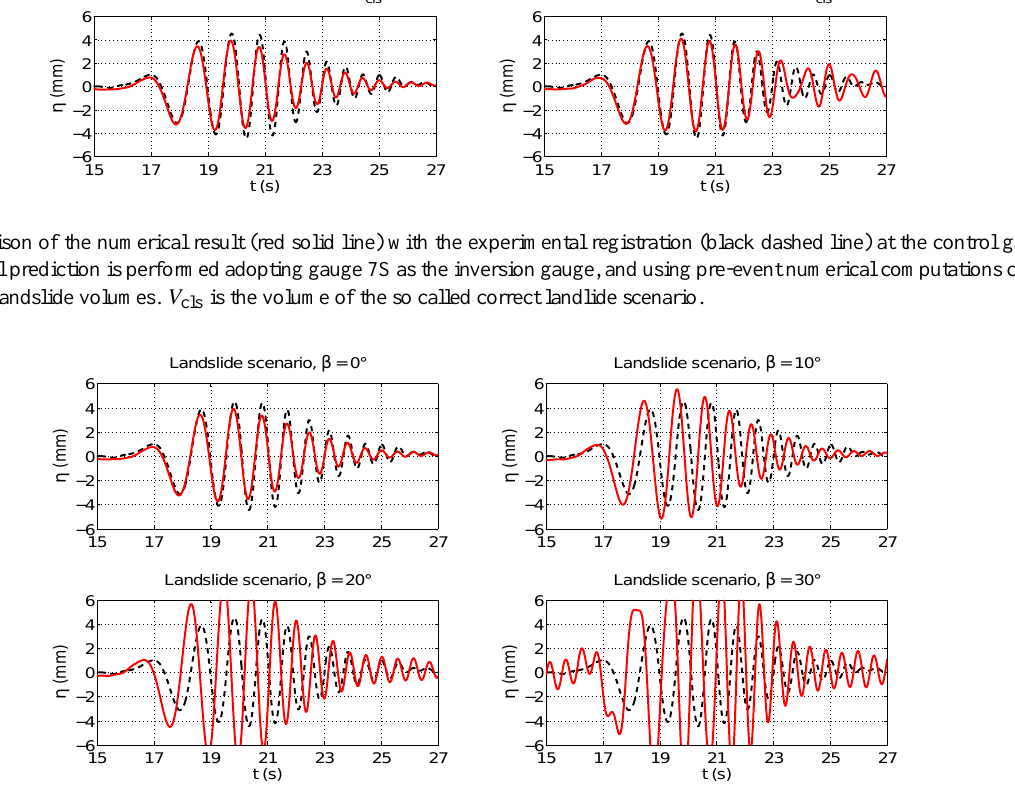
Fig. 7. Comparison of the numerical result (red solid line) with the experimental records (black dashed line) at the control gauge 24S, using inversion gauge 7S. Numerical model prediction is performed using pre-event numerical computations carried out with 4 tentative landslide motion directions. The angle β measures the difference between the correct landslide scenario and that used in the computations. β = 0 ◦ represents the correct landslide scenario, i.e., that representing the